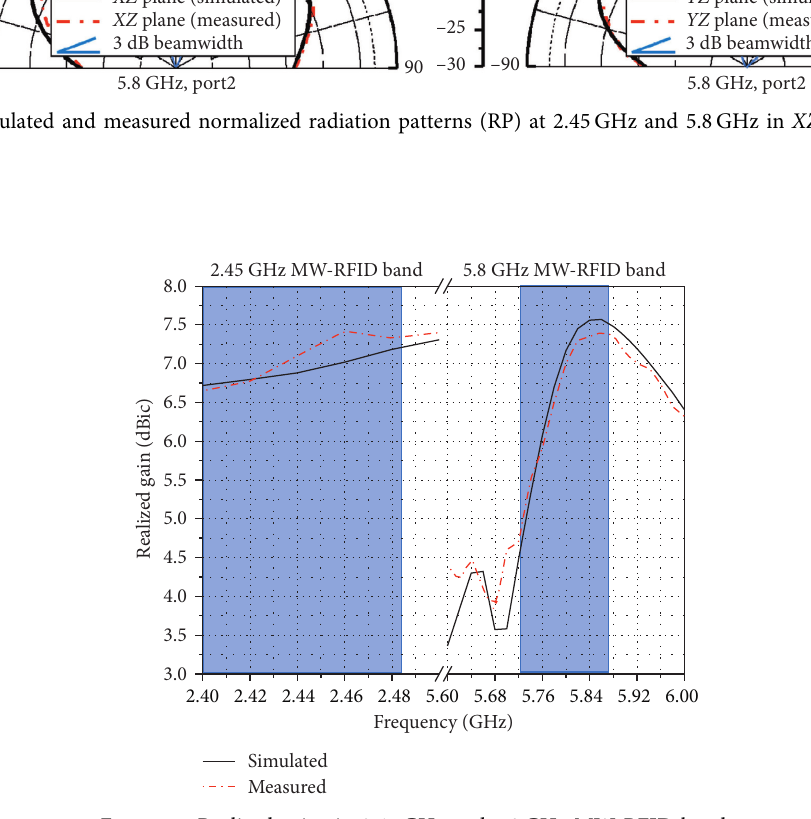
Figure 7: Realized gains in 2.45GHz and 5.8GHz MW-RFID